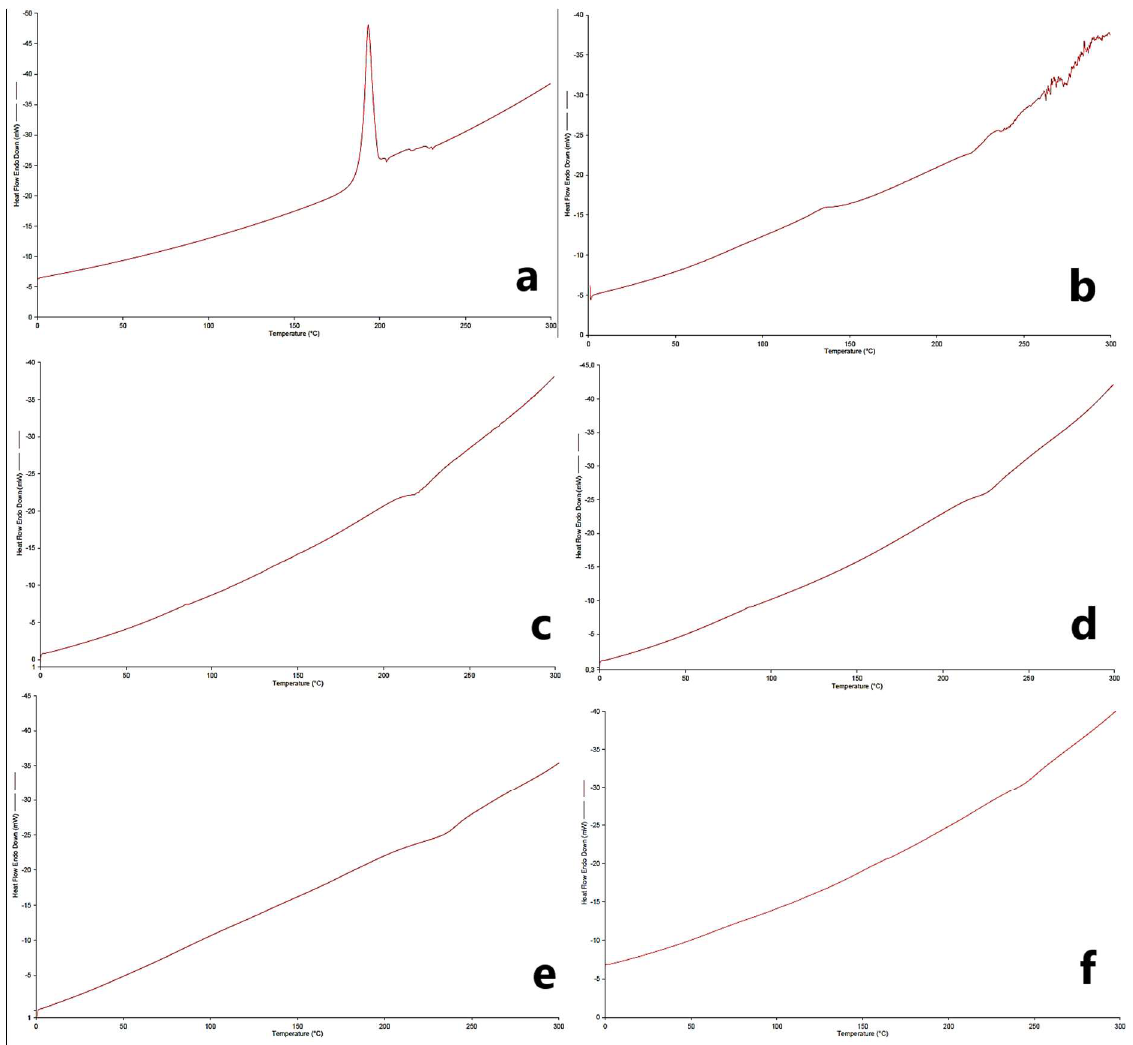
Figure 7 . DSC thermograms of pure drugs, optimum formulations, and physical mixtures ( a ) PG, ( b ) MC, ( c ) F5, ( d ) F8, ( e ) F13, and ( f ) physical mixture) .